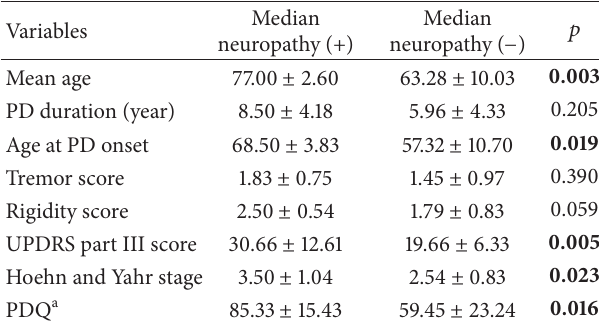
Table 1: The clinical characteristics of the patients and the control group.